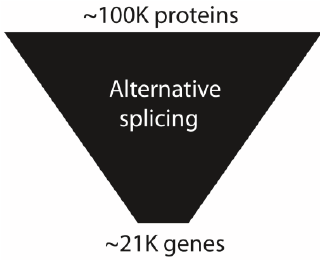
Figure 7. Alternative splicing amplifies genome information. Alternative splicing amplifies information in the human transcriptome relative to the